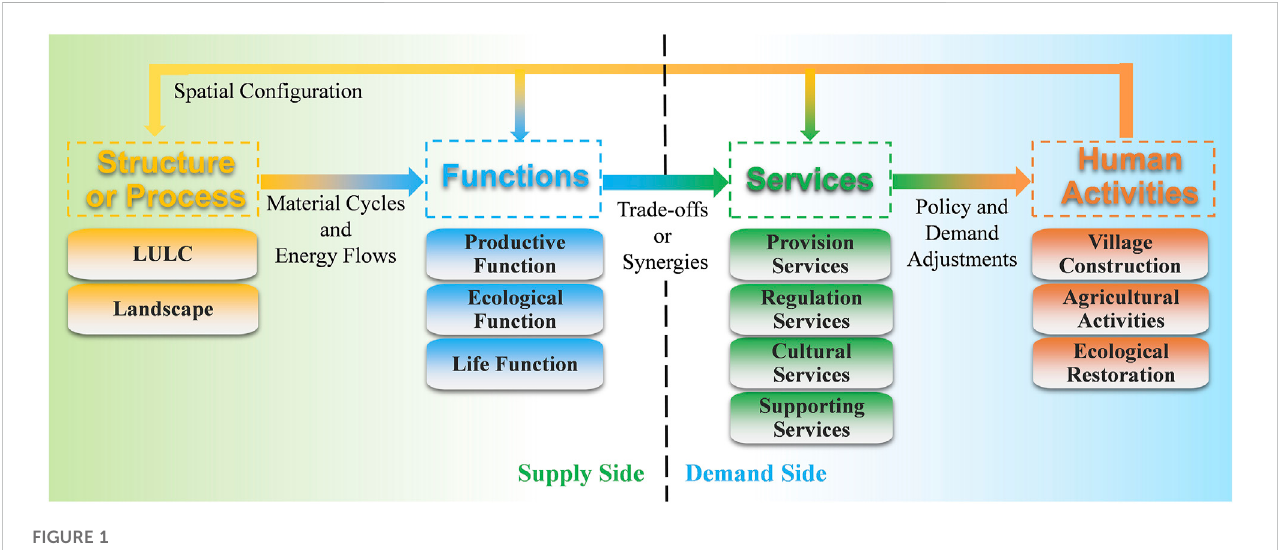
FIGURE 1 A logical framework for the cyclical management of village